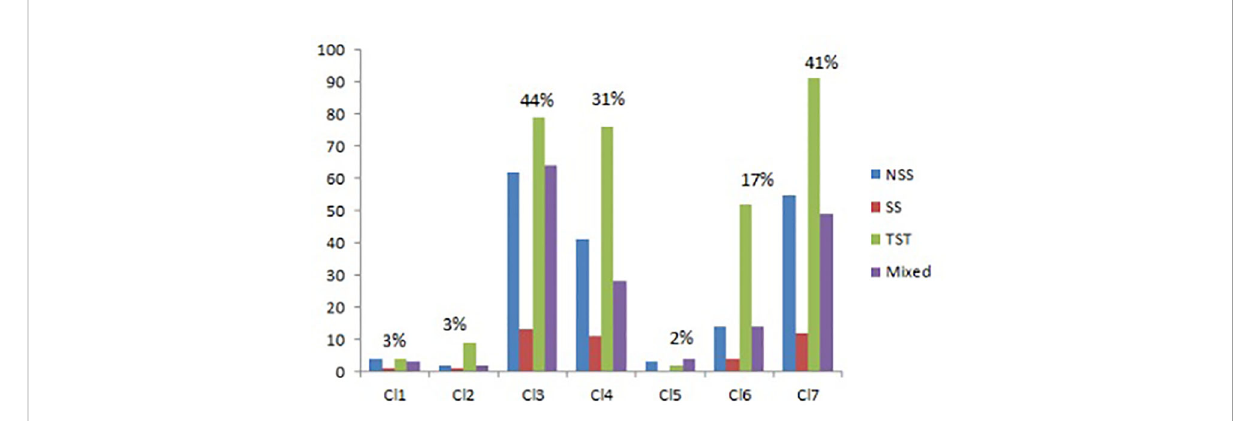
FIGURE 6 The classi fi cation and subgroup distribution of leaf midrib curve. CL1, vertical type; Cl2, Tip curved type; CL3, Stretch type; CL4, Bending type; CL5, Creeping type; CL6, Drooping type; CL7, De fl ection